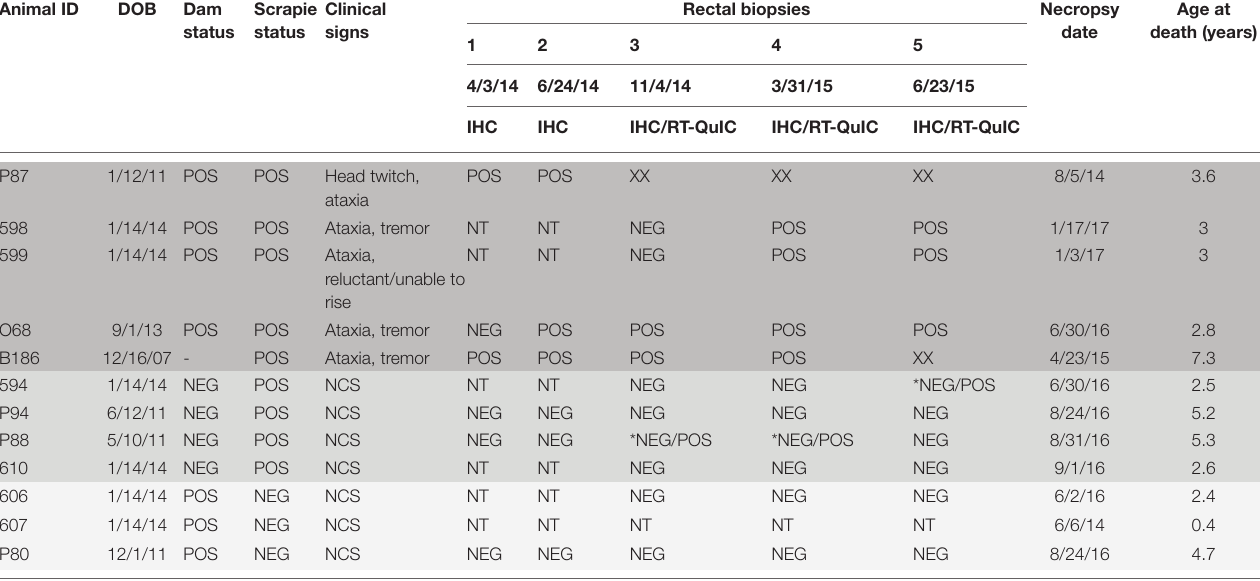
TABLE 1 | Immunohistochemistry and RT-QuIC of serial RAMALT biopsies. Animal